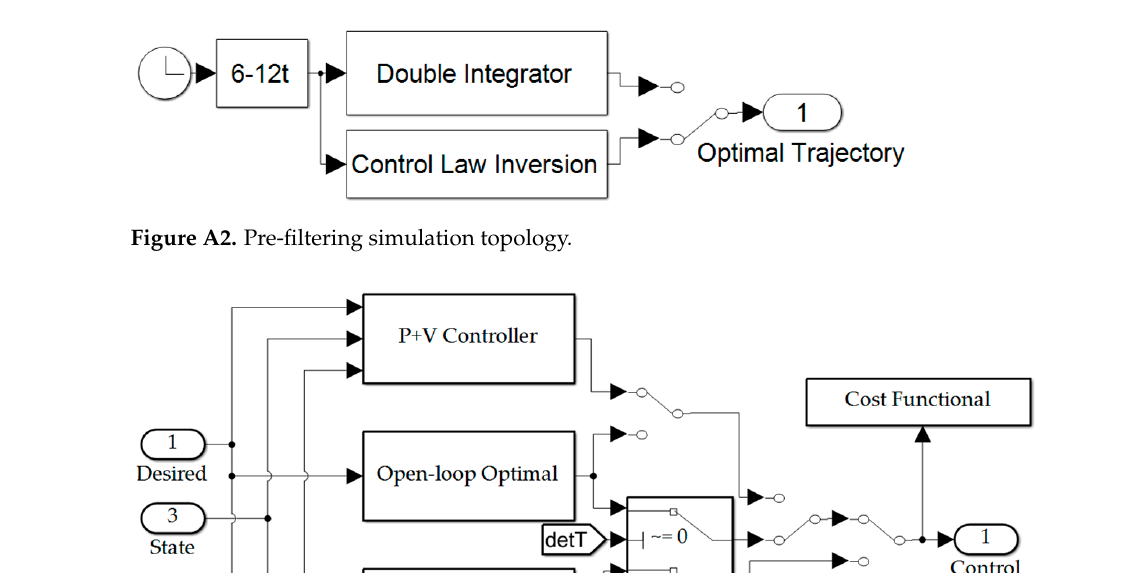
Figure A1. Patching fi lter simulation topology.